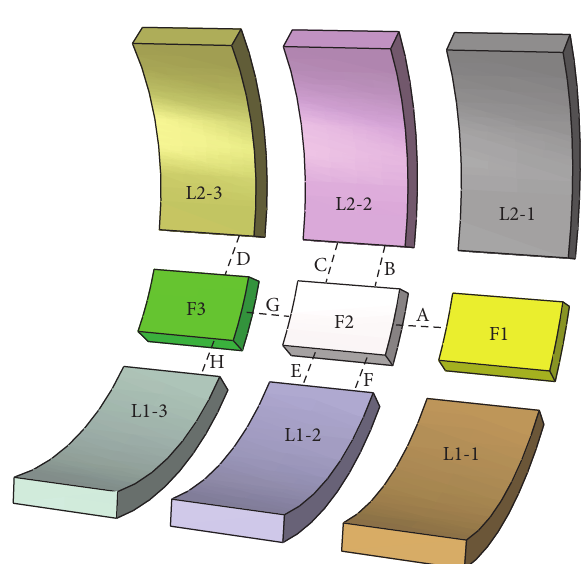
Figure 11: Schematic diagram of the bolt failure position.